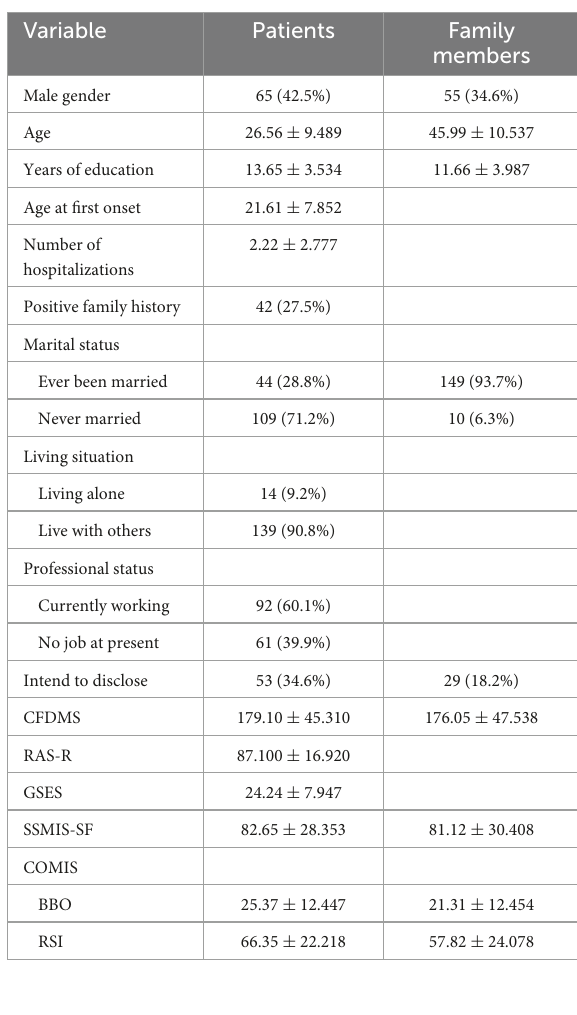
TABLE 1 Description of the sample